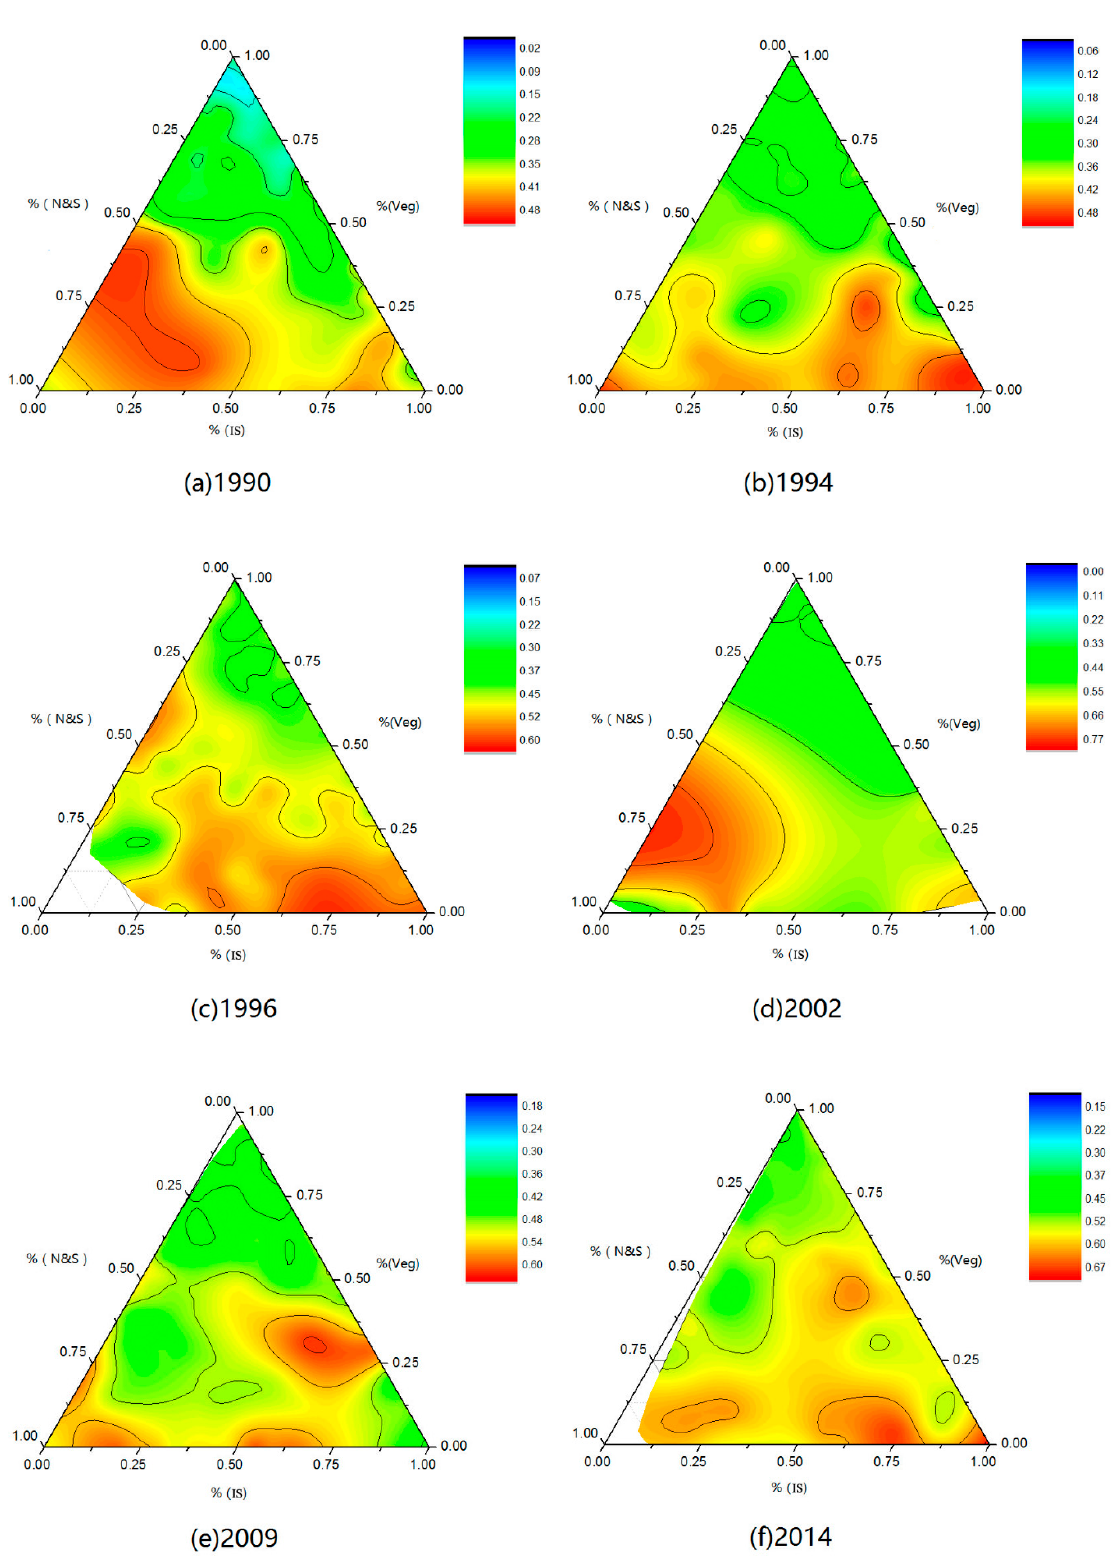
Figure 8 . Ternary triangle contour graphics of endmember fraction with normalized LST. Figure 8. Ternary triangle contour graphics of endmember fraction with normalized